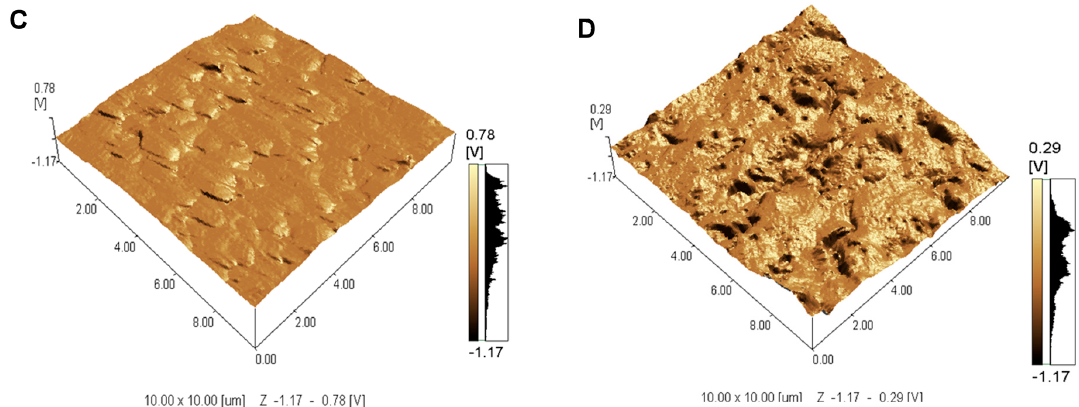
Figure 2. Representative three-dimensional AFM images of the leaf midribs ( A , B ) and latex ( C , D ) of healthy ( A , C ) and PMeV-infected papaya plants ( B , D ). The microstructures of the healthy leaf midribs and latex ( A , C ) show smooth surfaces, whereas the infected leaf midribs and latex have rough surfaces ( B , D ).